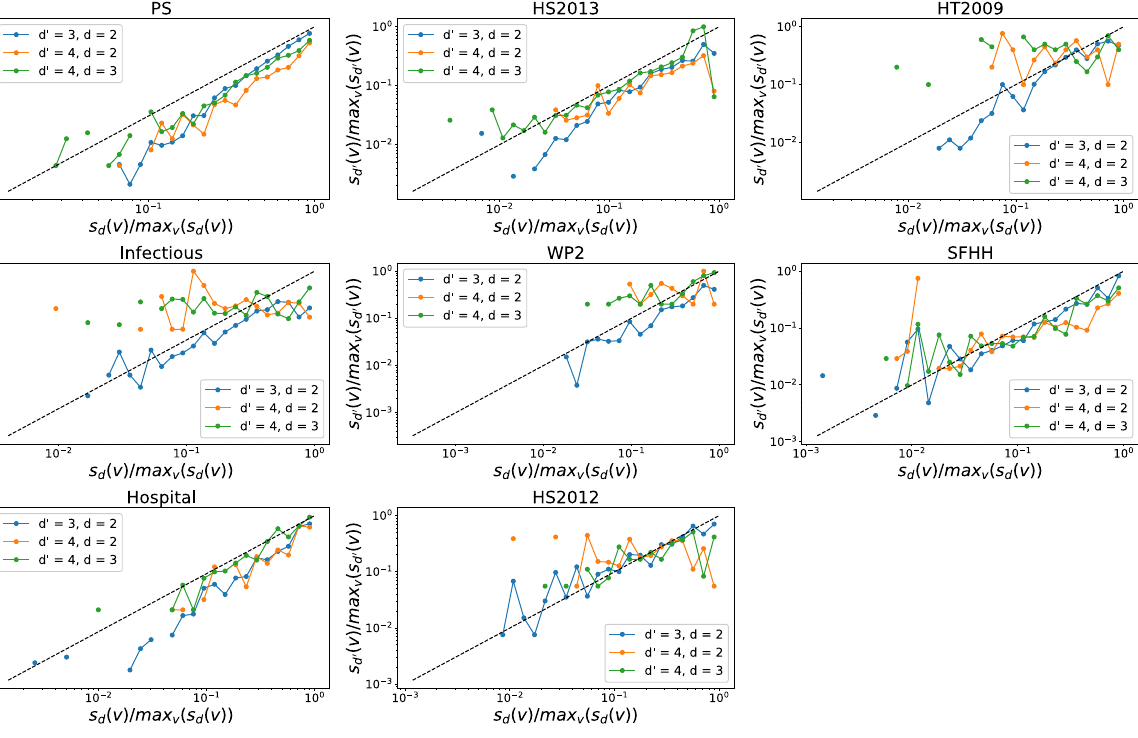
Figure 7. The d ′ -strength s d ′ ( v ) versus the the d -strength s d ( v ) of a node v when ( d ′ , d ) is equal to (3,2) (blue line), (4,2) (yellow line) and (4,3) (green line) respectively in each physical contact network. Each axis (e.g., s d ( v ) ) has been normalized by its maximum (e.g., max v ( s d ( v )) ). Only nodes whose d -strength and d ′ -strength are both non-zero are considered. The dashed line represent the reference